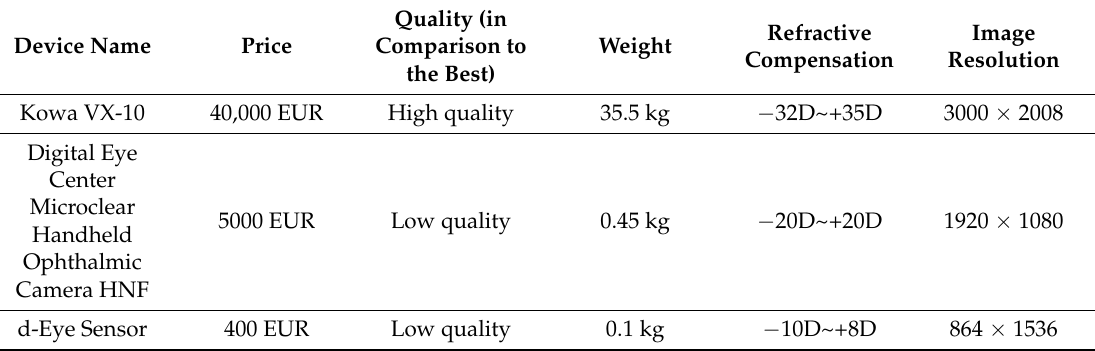
Table 1. Comparison of all device